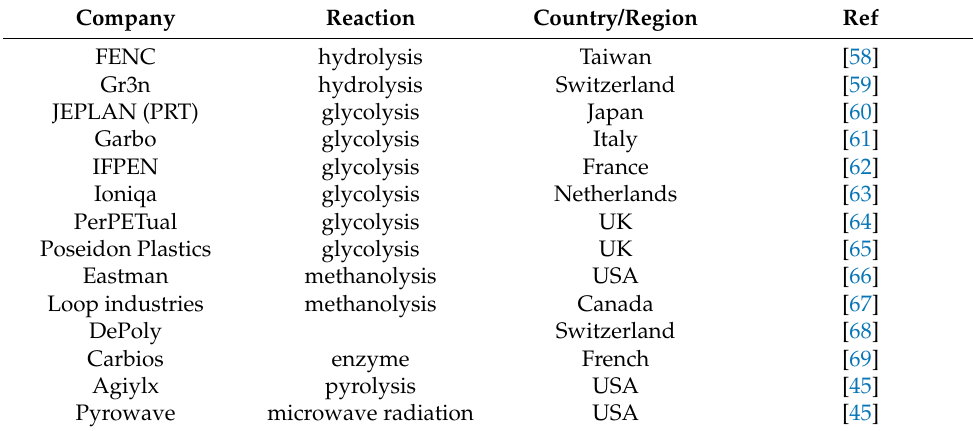
Figure 4. The 8 possible reactions of recycling PET including methanolysis, glycolysis, hydrolysis, ammonolysis and aminolysis. Table 1. Industrial rPET production and their